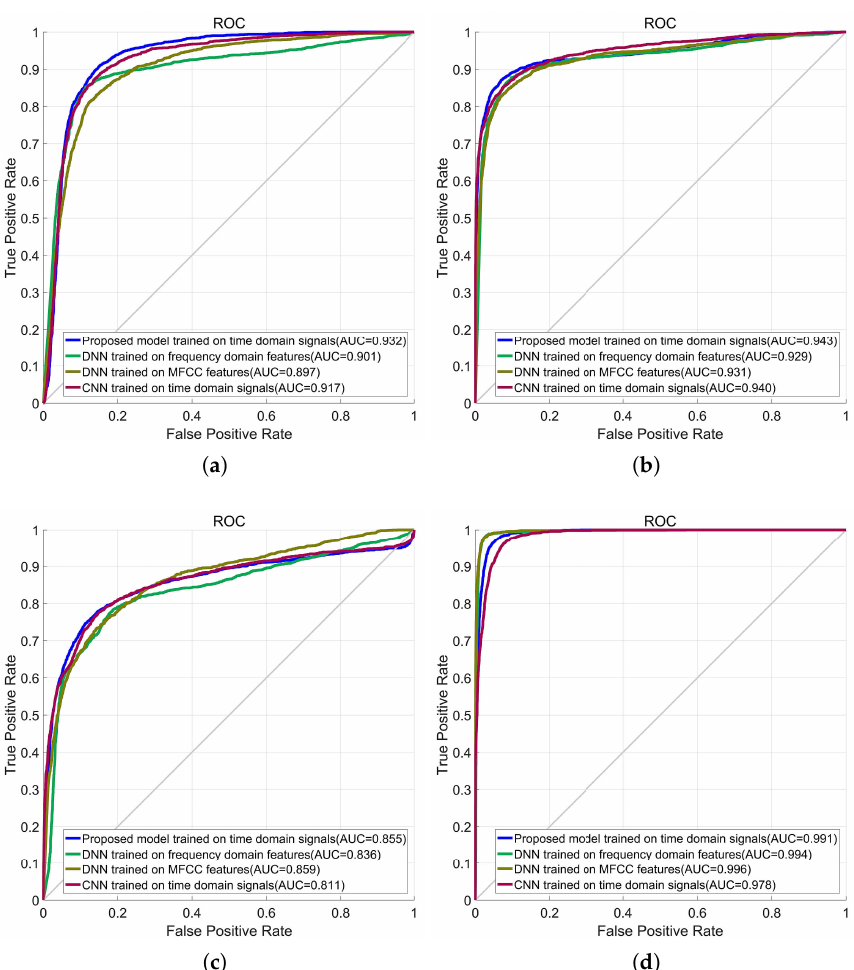
Figure 5. ROC curves of the proposed model and its competitors. ( a ) Cargo class is positive class; ( b ) Passenger ship class is positive class; ( c ) Tanker class is positive class; ( d ) Environment noise class is positive